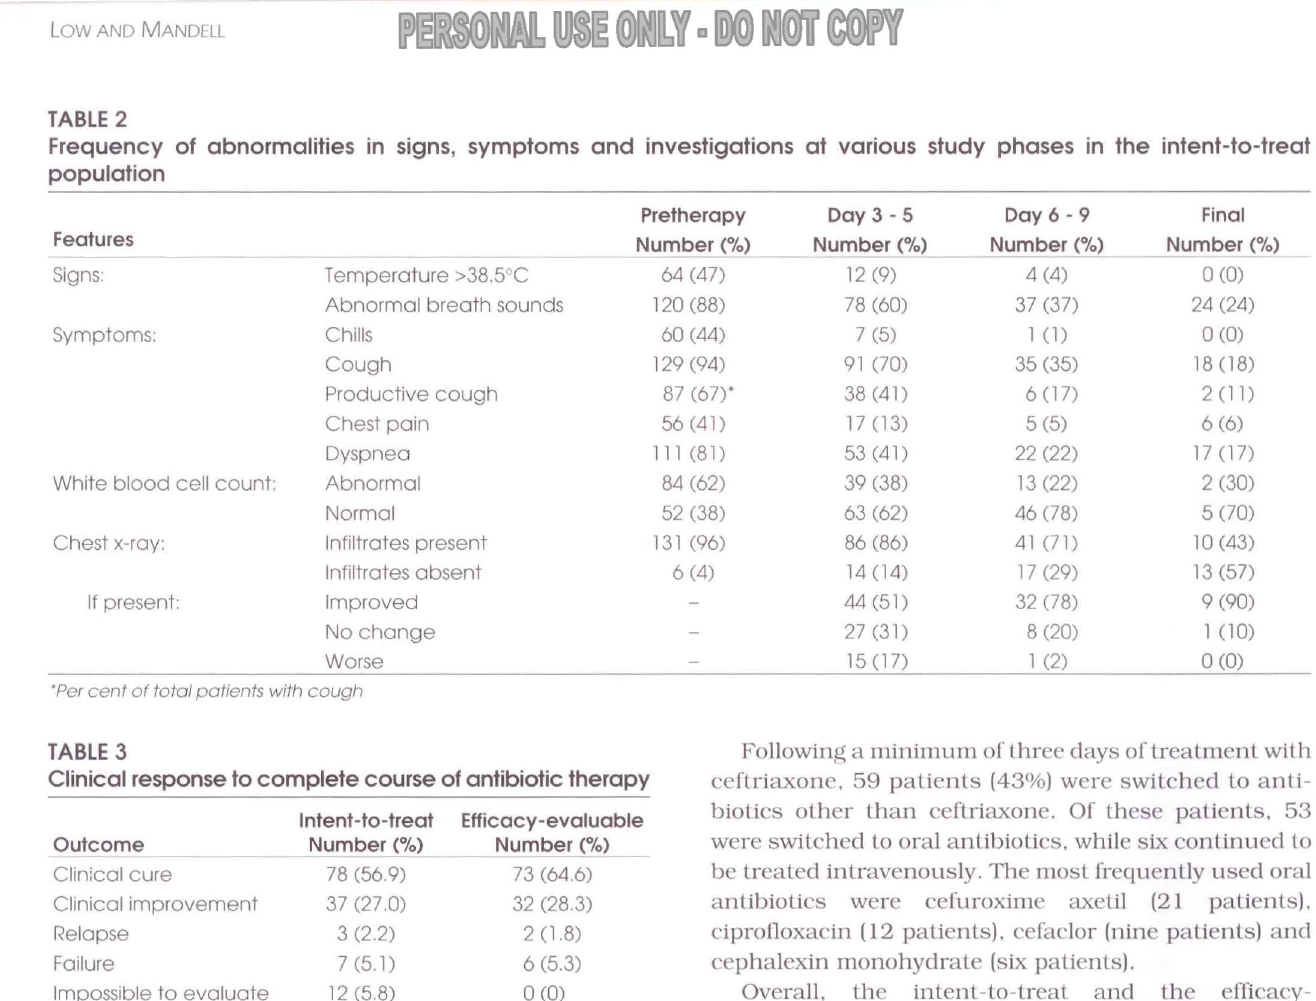
Following a minimum of three clays of treatment with Clinical response to complete course of antibiotic therapy ceftriaxone. 59 patients (43%) were switched lo anti Intent-to-treat Efficacy-evaluable Outcome